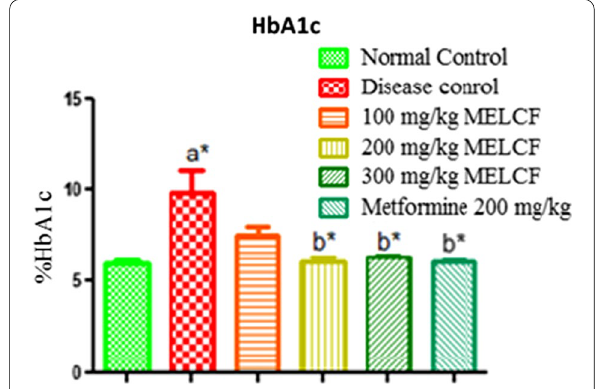
Fig. 5 Effect of MELCF on HbA1c. The values represented as mean SEM ( n 6). a* ( p < 0.05) when compared to normal control ± = and b* ( p < 0.05) when compared to disease/diabetic control